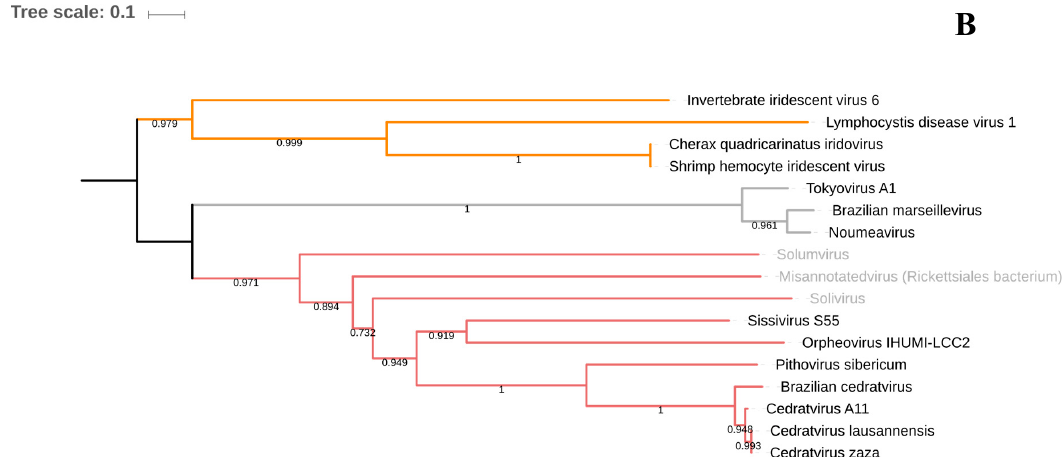
Figure 2. Phylogenetic trees based on DNA polymerase B of giant viruses ( A ) and on VETF gene to illustrate the clustering of Pithoviridae and Sissivirus ( B ). The viruses described only in metagenomics are labeled in gray. The analysis was performed using Muscle and FastTree, applying the maximum-likelihood method with 1000 bootstrap replicates.